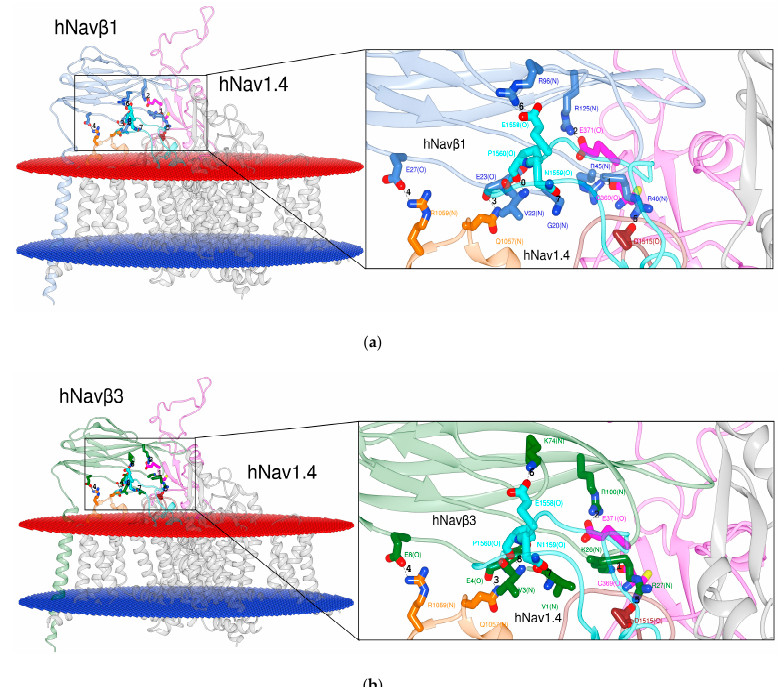
Figure 3. Display of PPI models. Based on the 3D template in ( a ) hNa v 1.4 α /hNa v β 1 [49]; based on a homology model in ( b ) hNa v 1.4 α /hNa v β 3 [49,55] for S6 DIV. The box presents atomic details at the interface. Labels 1 to 8: Ids of computed polar interactions (Table S1, Supplementary Materials); the amino acids are labeled by one-letter-codes with their primary sequence residue numbers and interacting atoms in parentheses, e.g. bottommost D1515(O). Colors: extracellular membrane boundaries (dark red); intracellular membrane boundaries (navy blue); transmembrane and intracellular protein regions of Na v α that do not participate in PPI (gray); Na v β 1 subunit (cornflower blue); Na v β 3 subunit (forest green); S5 DI: magenta; S1-S2 DIII: orange; S5 DIV: brown; S6 DIV: cyan); computed polar interactions: black dotted lines. Visualization achieved by Chimera Alpha 1.14 [61].